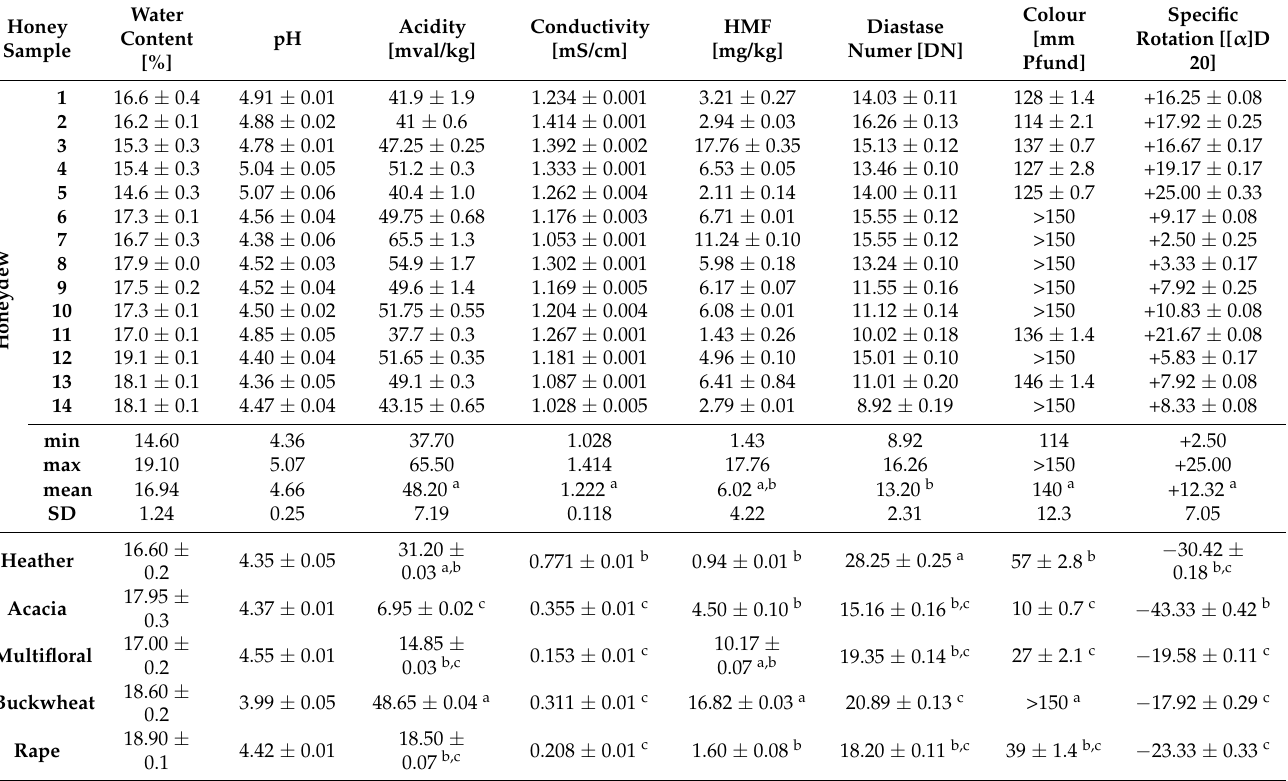
Table 1. The physicochemical parameters of honeydew and nectar honey expressed as mean ± SD, both included in legal requirements (water, pH, acidity, conductivity, HMF, and diastase number), and not legally required (color and specific